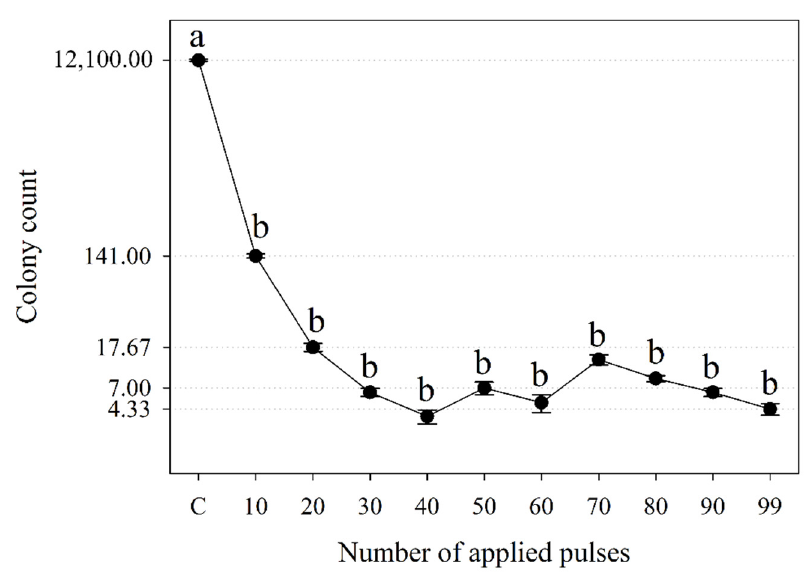
Figure 4. E. coli DH5 α inactivation dependence on the number of pulses at 24 kV/cm voltage, after 24 h of incubation in agar plates at 37 °C. The abscissa shows the number of pulses used during the experiment; the ordination axis presents the mean of colony count. C—Control (raw milk). Control and PEF-treated suspensions were diluted with pasteurized (UHT) milk at ratio of 1:100. Different lowercase letters indicate significant differences between the samples ( p < 0.05). Table 1. Bacterial count in milk samples treated with different pasteurization techniques: RM—raw milk (control); PEF—pulsed electric field; LTLT—low-temperature long-time; UHT1—ultra-high temperature; UHT2—ultra-high temperature; UHT3—ultra-high temperature, MF1— microfiltration; MF2—microfiltration after 24 h of incubation in agar plates at 37 °C. Note: results are expressed as mean ± standard deviation (SD).